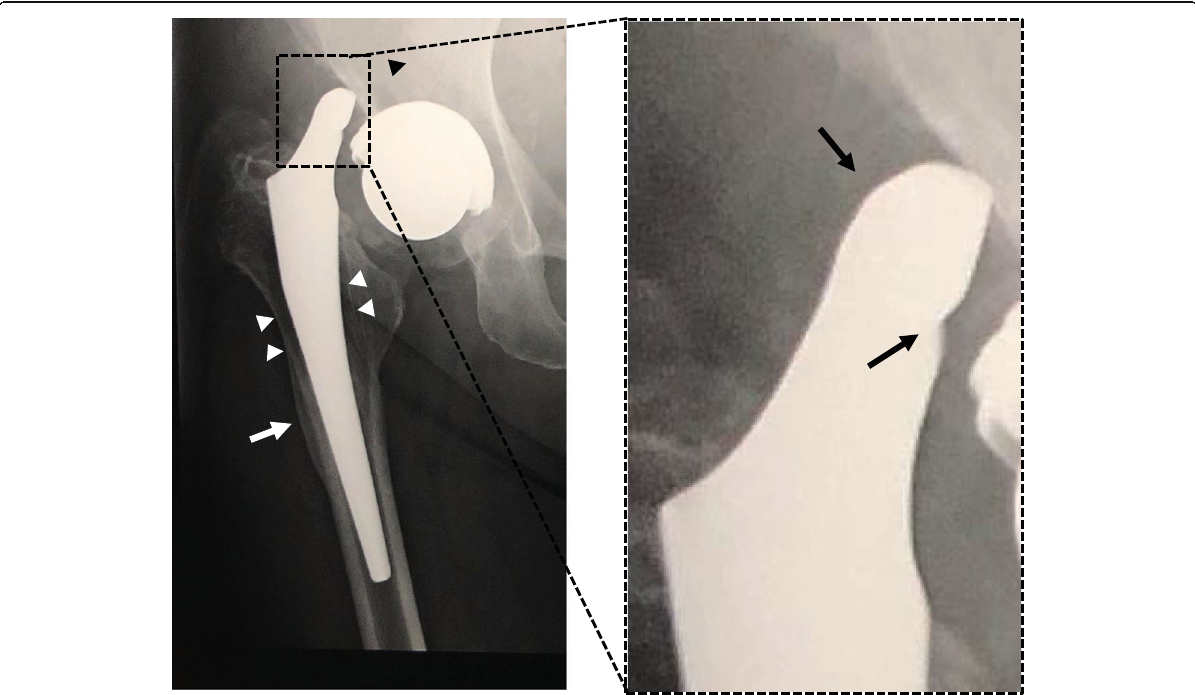
Fig. 2 Radiography obtained 7.5 years after total hip arthroplasty (THA). There is dissociation of the femoral head from the head-stem trunnion (right panel, box) after THA (right panel, black arrows), radiolucency (left panel: black arrowhead, and white arrowheads), and cortical hypertrophy